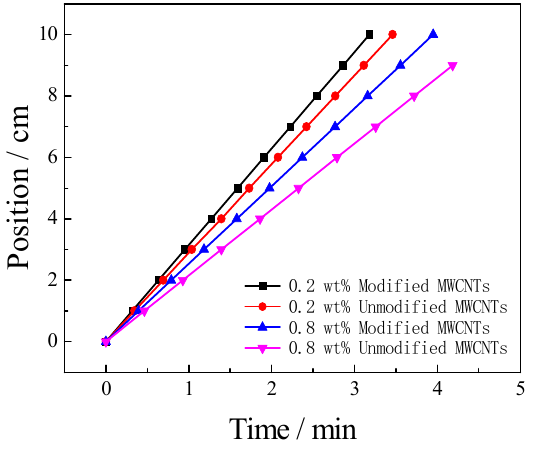
Figure 5. Front position versus time for the photoinduced FP of MWCNTs / epoxy resin. Table 1. The V f of the photoinduced FP of MWCNTs / epoxy resin. Content of MWCNTs (wt